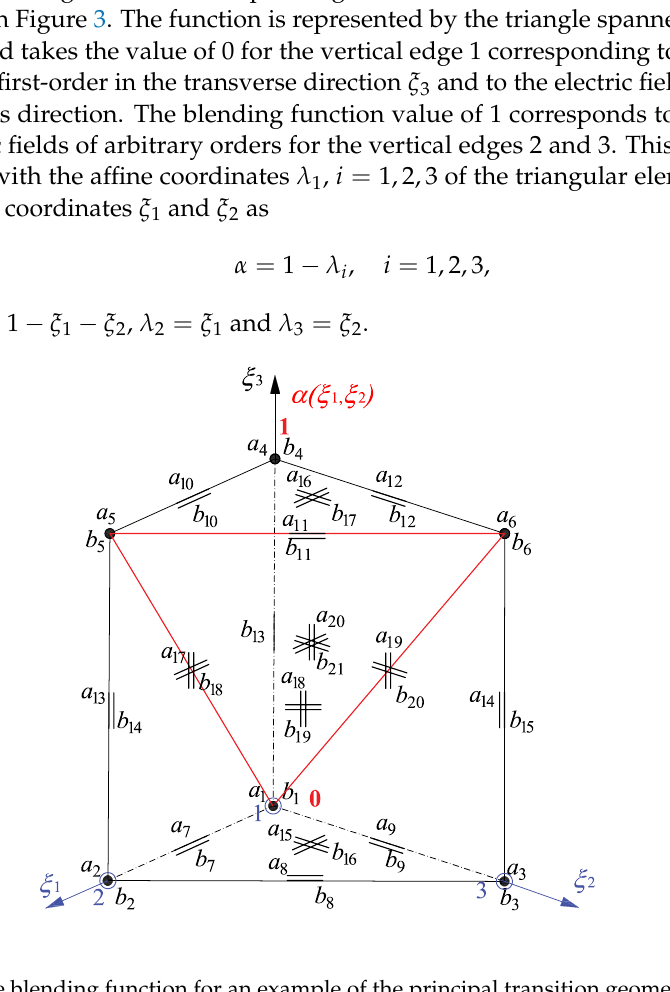
Figure 3. The blending function for an example of the principal transition geometry